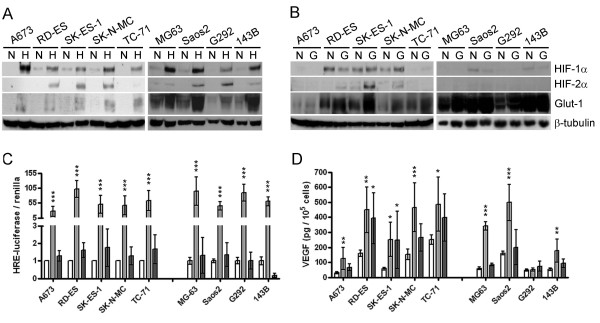
HIF induction in ES and OS cell lines. Western blots showing induction of HIF-1α (120 kDa), HIF-2α (120 kDa) and Glut-1 (50 kDa) in a panel of ES (A673, RD-ES, SK-ES-1, SK-N-MC, TC-71) and OS (MG-63, Saos2, G292, 143B) cell lines in response to 24 h (a) hypoxia (H; 0.1% O2) or (b) low glucose (G; over-exposed in comparison to hypoxia blots) compared with the untreated/normoxic (N) control. (c) Activation of the HRE-luciferase reporter construct and (d) secretion of VEGF in response to hypoxia (light grey bars) or low glucose (dark grey bars). *, p < 0.05; **, p < 0.01; ***, p < 0.001.